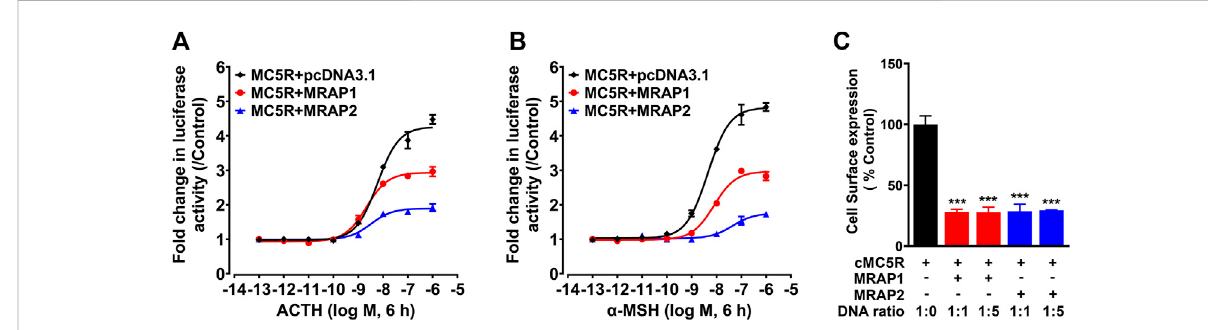
FIGURE 3 (A) Effect of ACTH in activating chicken MC5R expressed in CHO cells co-transfected with cMRAP1 or cMRAP2 expression plasmid, as monitoredbythepGL3-CRE-luciferase reportersystem. (B) Effectofa-MSHinactivating chickenMC5RexpressedinCHOcellsco-transfected with cMRAP1 or cMRAP2 expression plasmid, as monitored by the pGL3-CRE-luciferase reporter system. Data are shown as the mean ± SEM of four replicates ( N = 4) and are representative of three independent experiments. (C) Surface expressions of chicken MC5R in CHO cells transfected with MC5Rand MRAP1 (orMRAP2) attheindicated ratioweremeasuredbytheHiBiT-taggingextracellulardetection system(Promega)and thetotal expression levels of HiBiT-MC5R measured by HiBiT lytic assay were used as an internal control to normalize transfection ef fi ciencies. Each fi gure shows one representative experiment repeated three times. ***, p < 0.001.